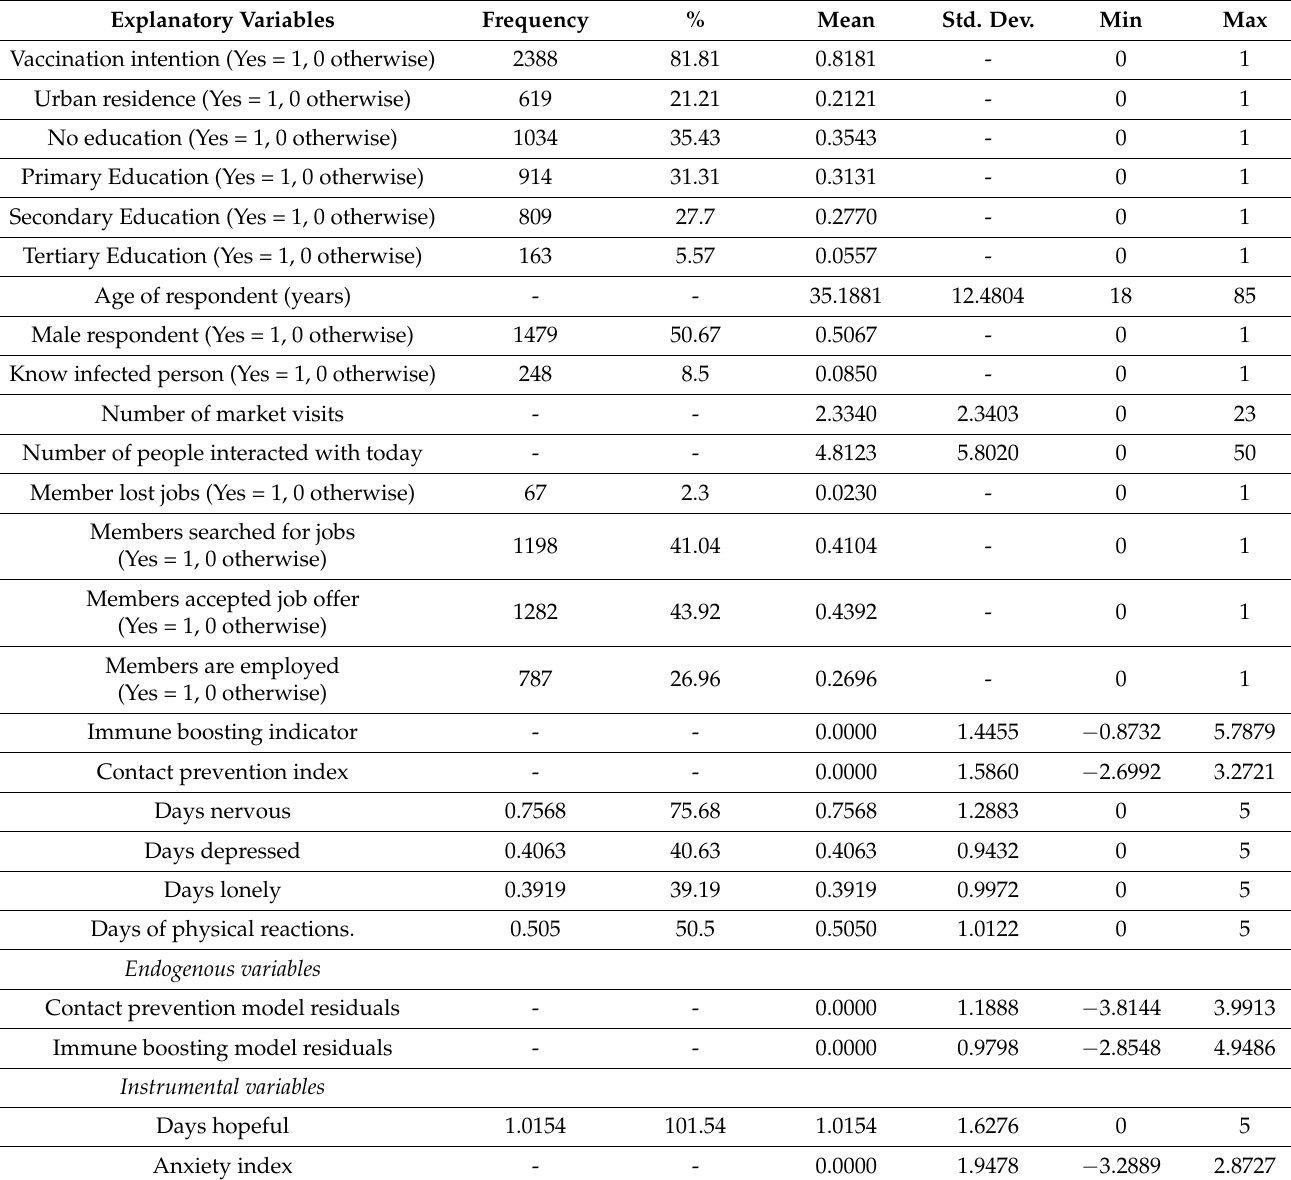
Table 1. Descriptive statistics of the selected explanatory